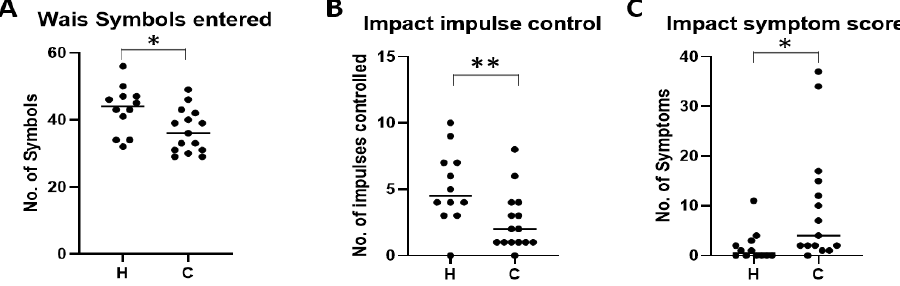
Figure 3. Outcomes of the Wechsler Adult Intelligence Scale (WAIS) symbol search and Impact test for concussion for the patients within this study. Following comprehensive clinical assessment of the WAIS symbol search and Impact test on healthy (H) and concussed (C) athletes it was found that the number of symbols entered ( A ), the impact on impulse control ( B ) and the impact symptom score ( C ) were significantly altered. Data is represented as the mean and individual data points were data was analyzed for significance using the unpaired T test where * p < 0.05, ** p < 0.01. WAIS symbol search n : H = 12, C = 15. Impact test n : H = 12 C = 15.